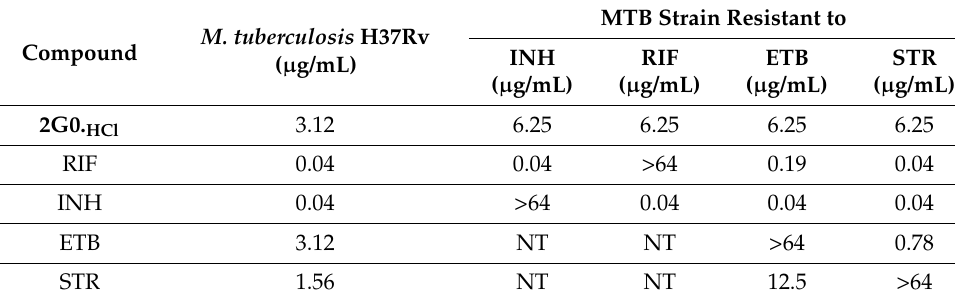
Table 4. Anti-TB activities of 2G0.HCl against single drug-resistant Mtb strains. Compound